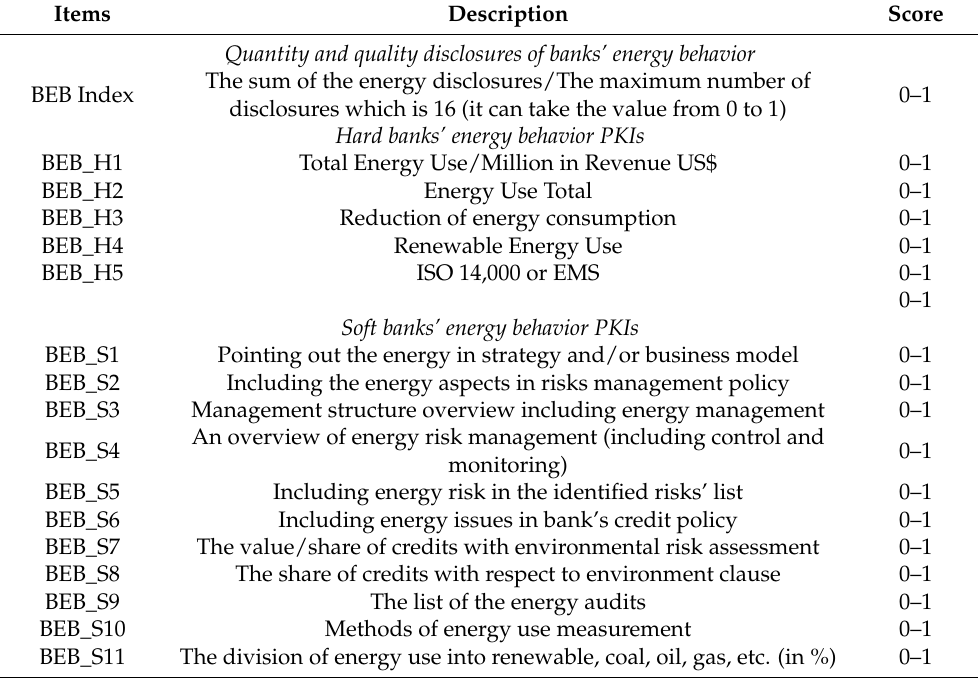
Table 1. The BEB index indicators.